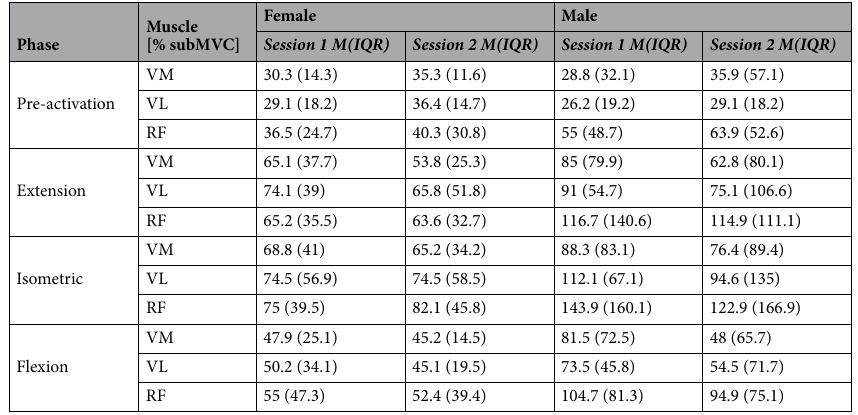
Table 4. Neuromuscular activity (% of the submaximal voluntary contraction) per sex and session. subMVC submaximal voluntary contraction; M median; IQR interquartile range.